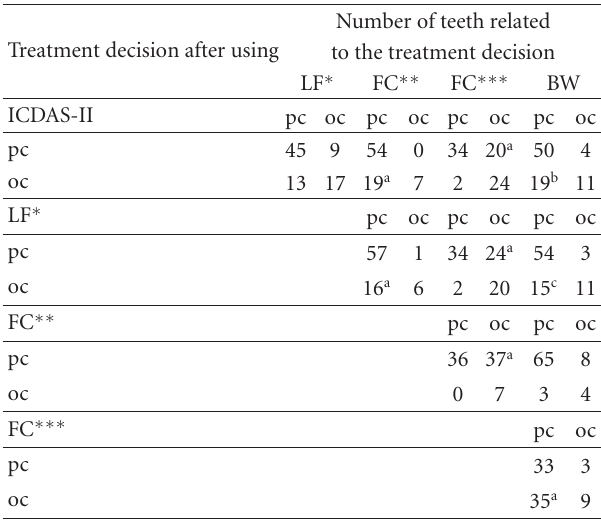
Table 4: Cross tables showing the relationship between the di ff erent methods and the treatment decisions.